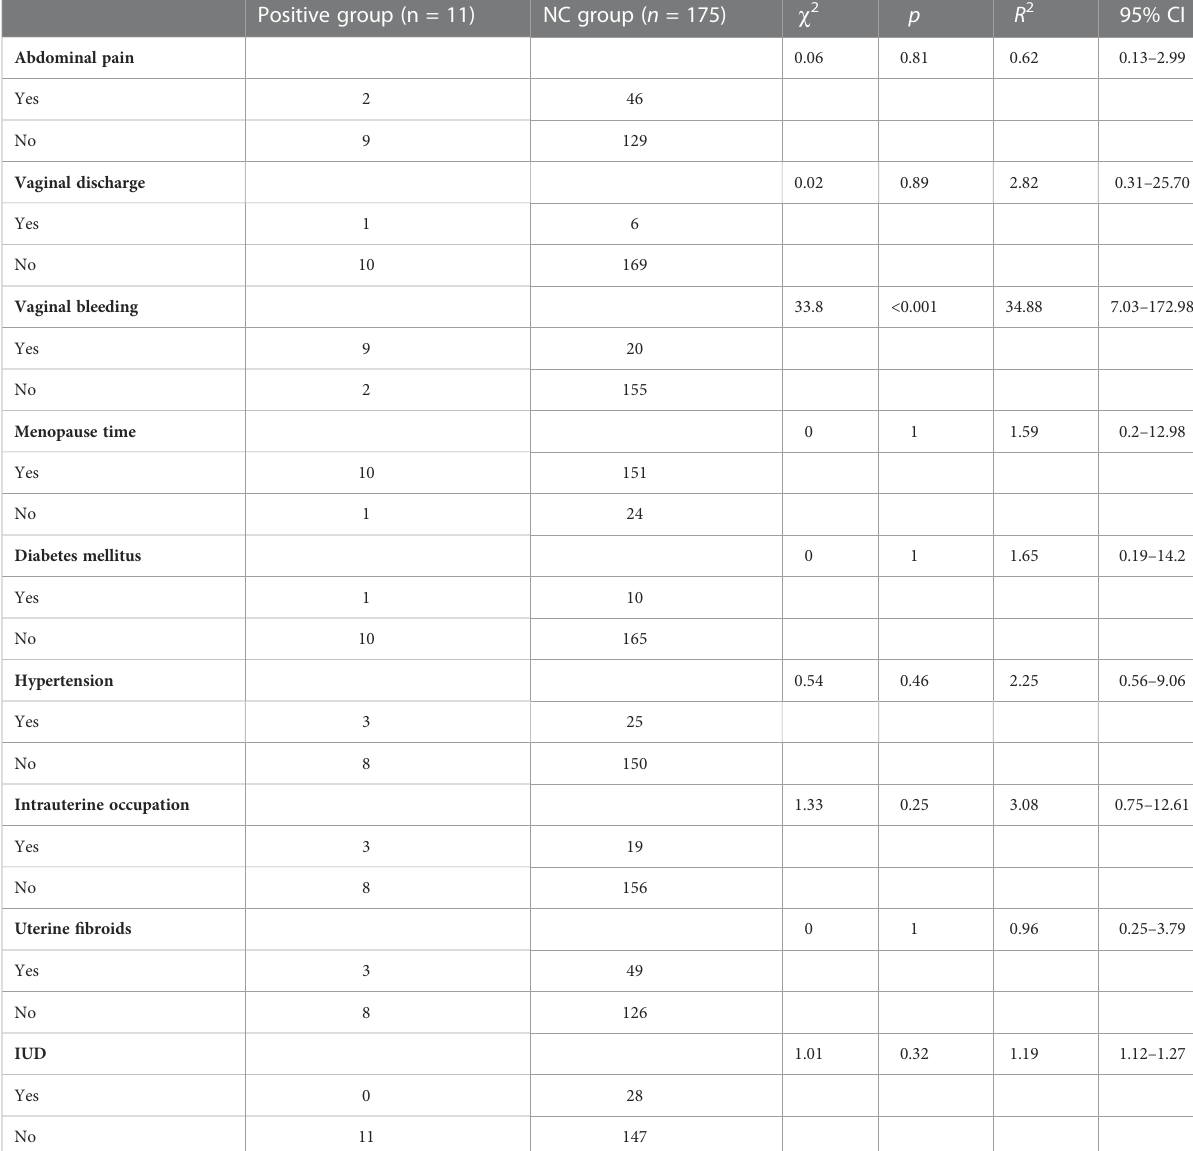
TABLE 4 Univariate analysis of risk factors for hydrometra complicated with gynecological